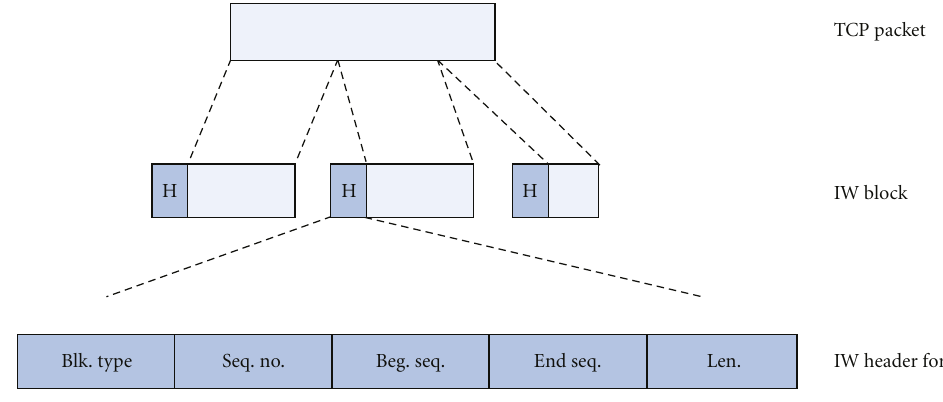
Figure 3: IW block header